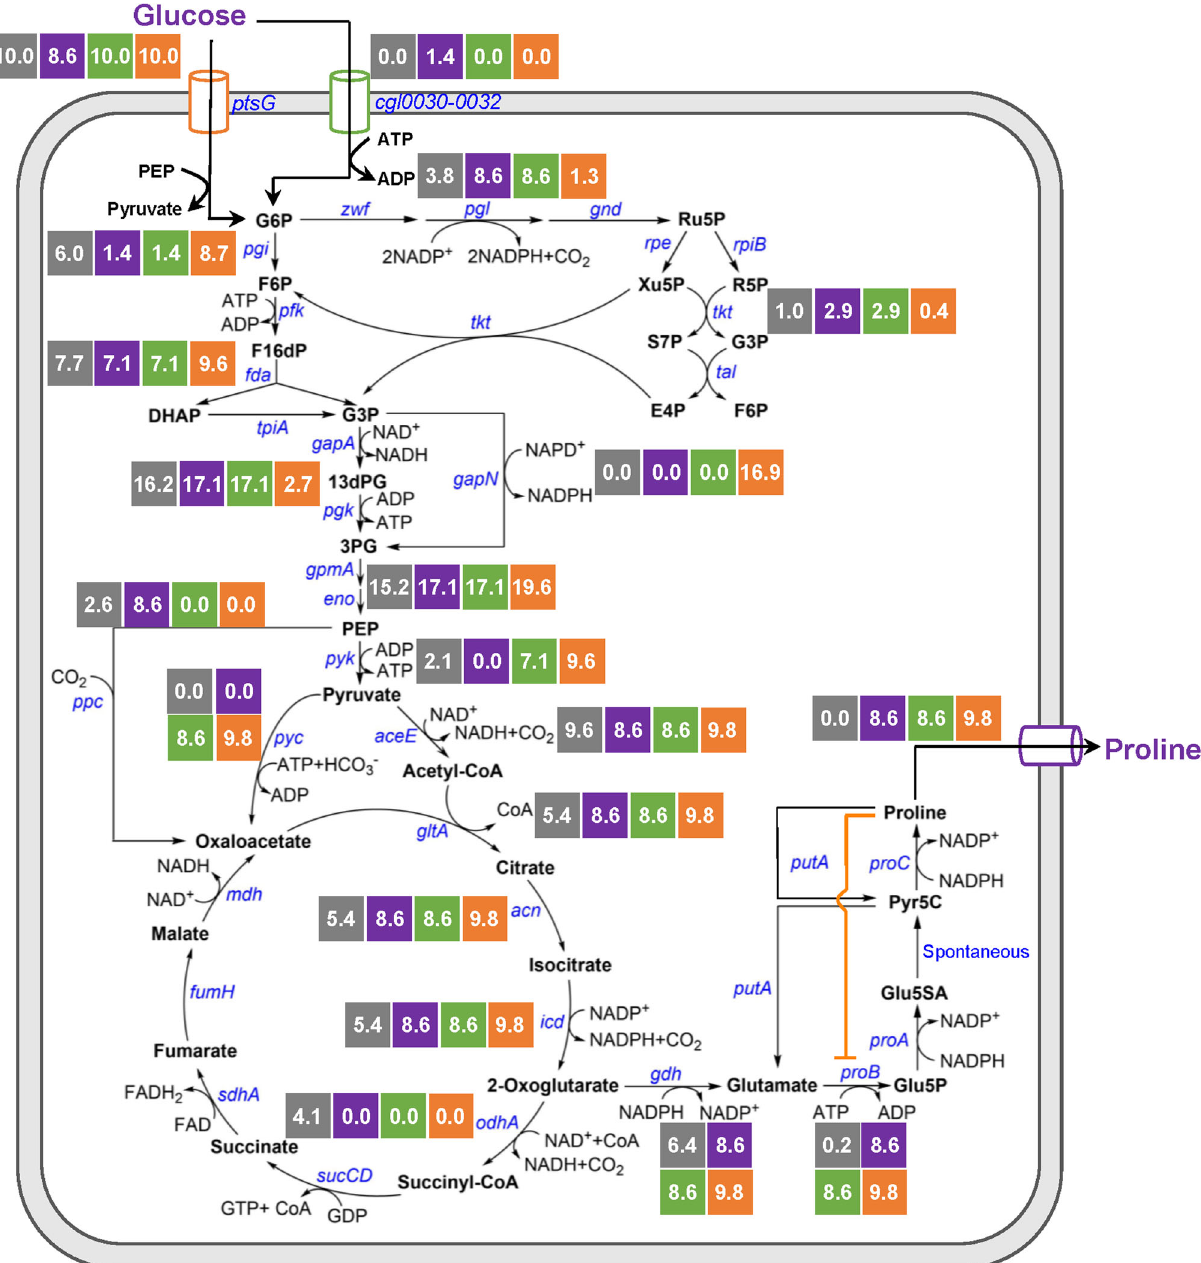
Fig. 2 In silico simulation of the L -proline biosynthetic pathway from glucose. Glucose input was set at 10 mmol/gCDW·h. The numbers in squares represent metabolic fl uxes of reactions. Grey squares represent the metabolic fl uxes for maximum biomass formation. Purple squares represent the metabolic fl uxes for maximum L -proline biosynthesis using the ppc -based C4 anaplerotic pathway. Green squares represent the metabolic fl uxes for maximum L -proline biosynthesis using the pyc -based C4 anaplerotic pathway. Orange squares represent the metabolic fl uxes for maximum L -proline biosynthesis using the gapN -based G3P oxidation pathway and pyc -based C4 anaplerotic pathway. The feedback inhibition of ProB by L -proline is indicated with orange line. Source data for in silico simulation are provided in Supplementary Data 3 –